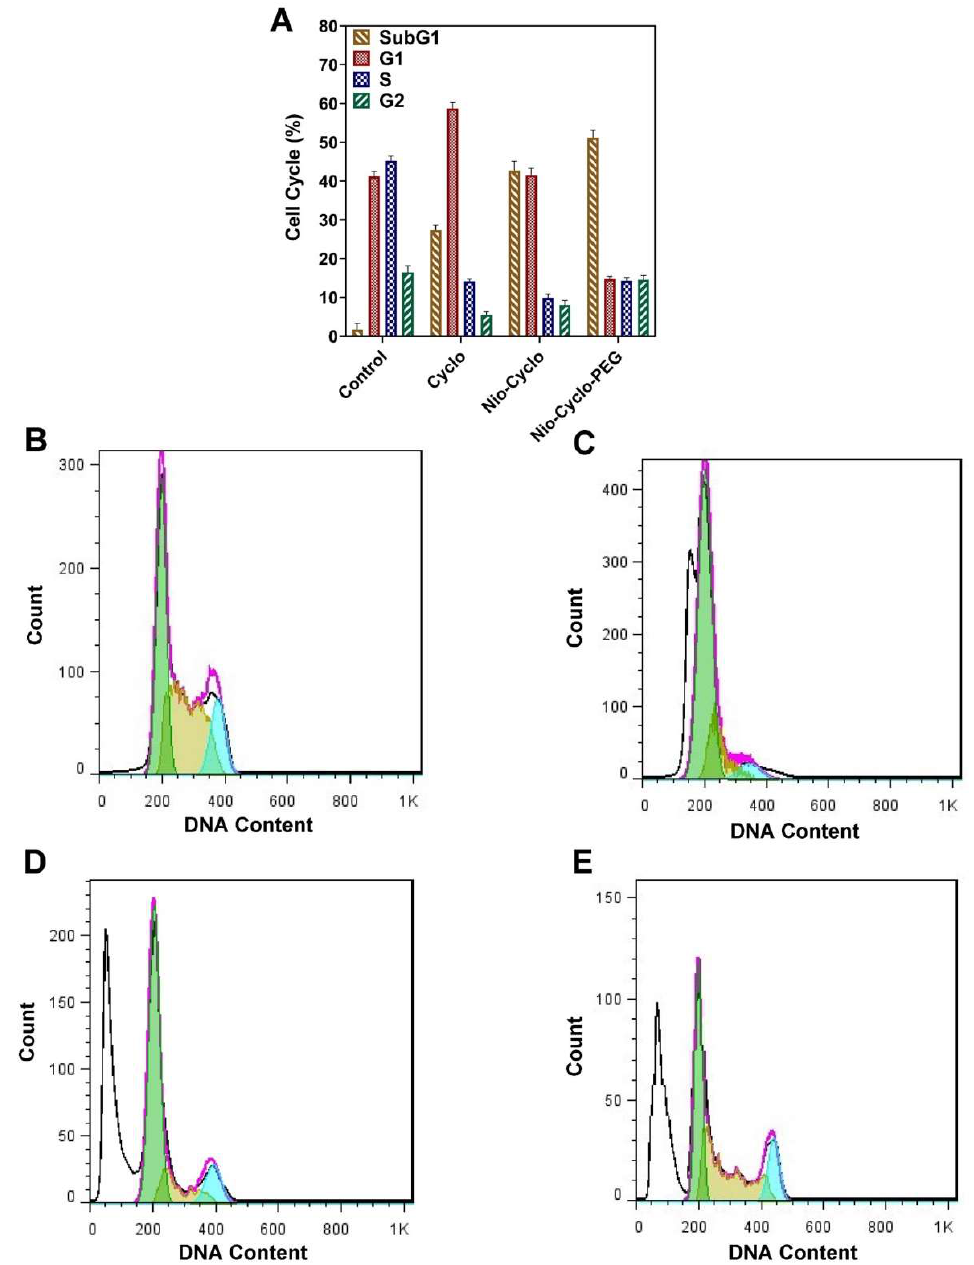
Figure 7. ( A ) Cell cycle analysis of different samples for AGS cancer cells. The AGS cell cycle analysis of different samples: ( B ) control, ( C ) Cyclo, ( D ) Nio-Cyclo, and ( E ) Nio-Cyclo-PEG. Data are represented as Mean ± SD from three independent experiments.